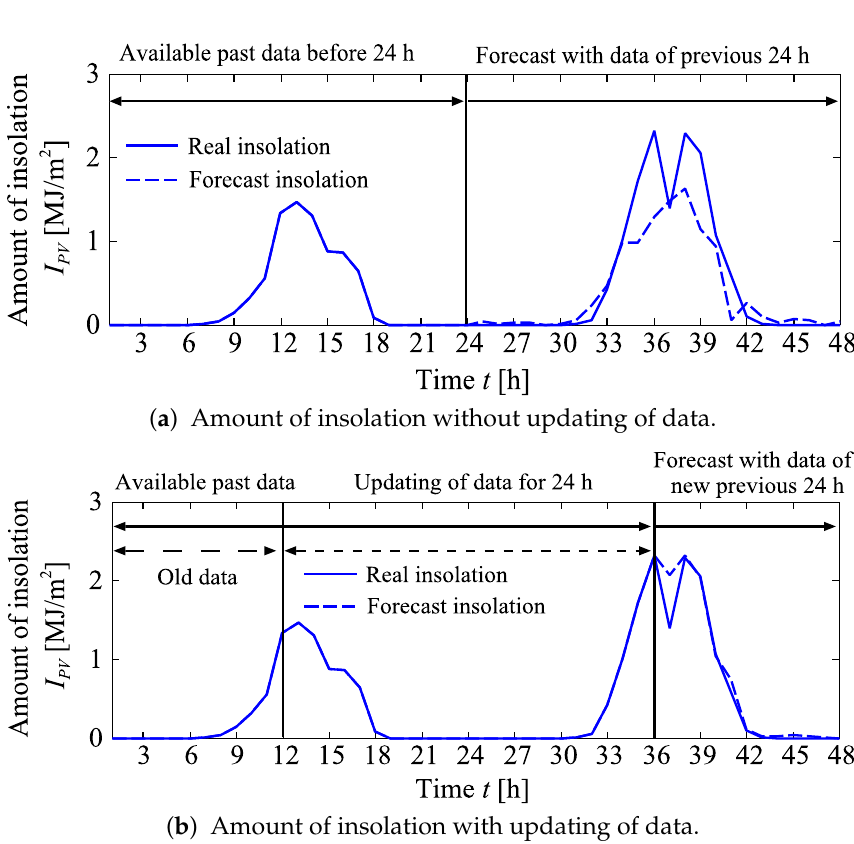
Figure 3. Overview and illustration of re-plan and re-forecast.